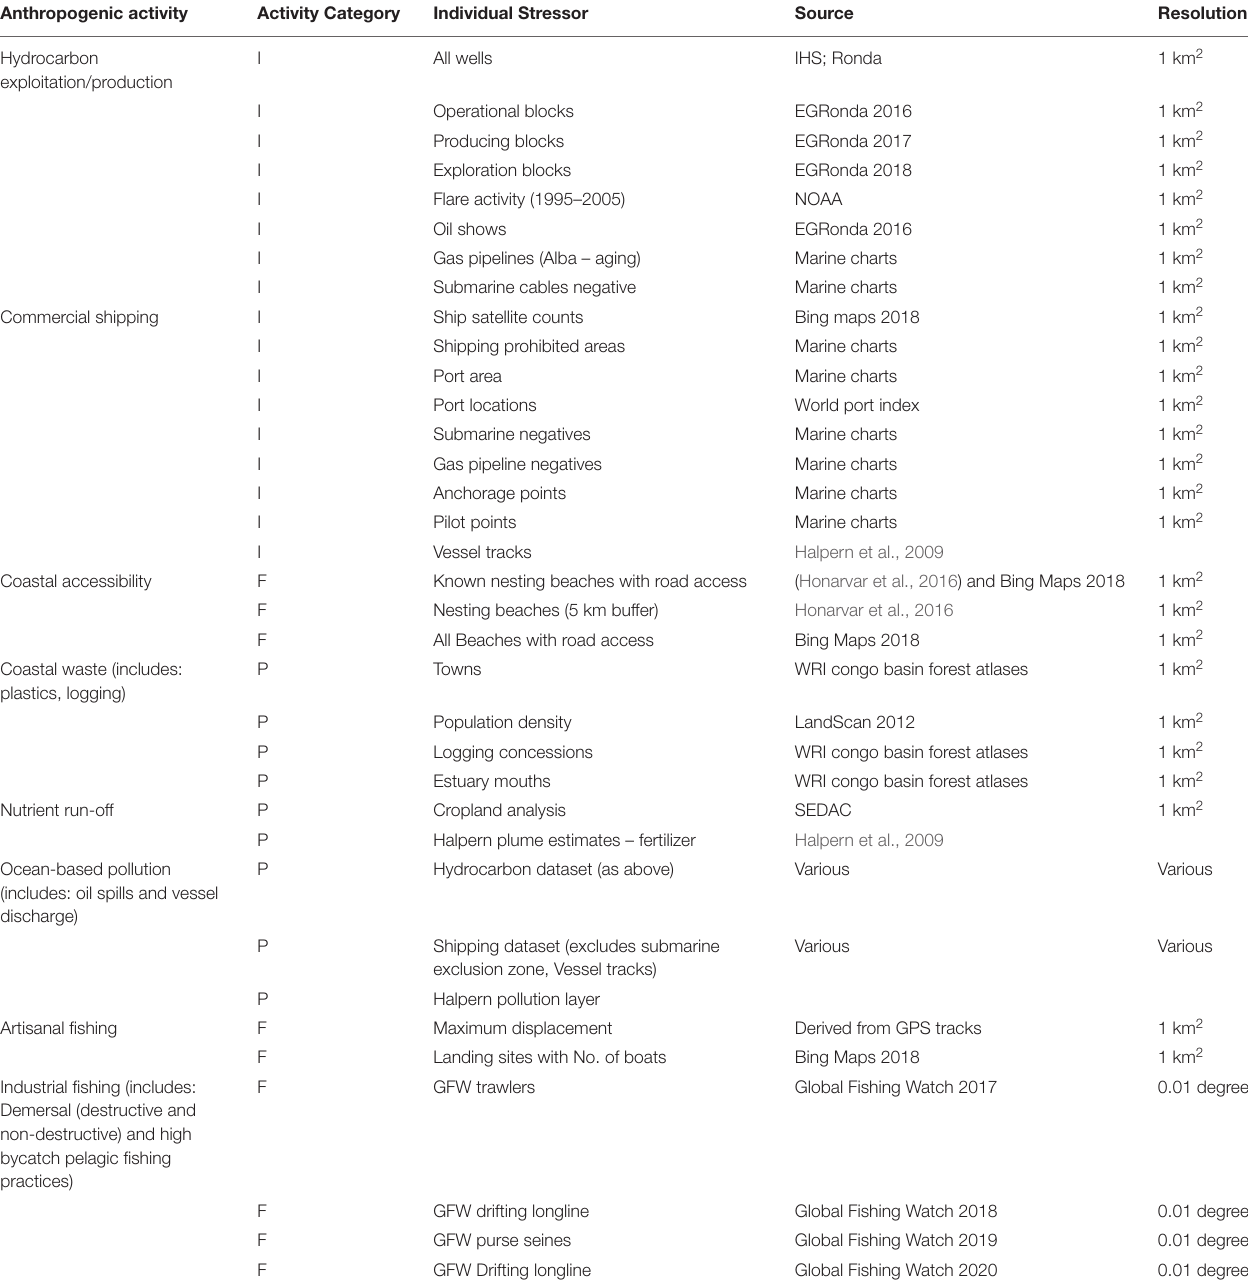
TABLE 1 | Details of data for anthropogenic drivers used in the analyses, including